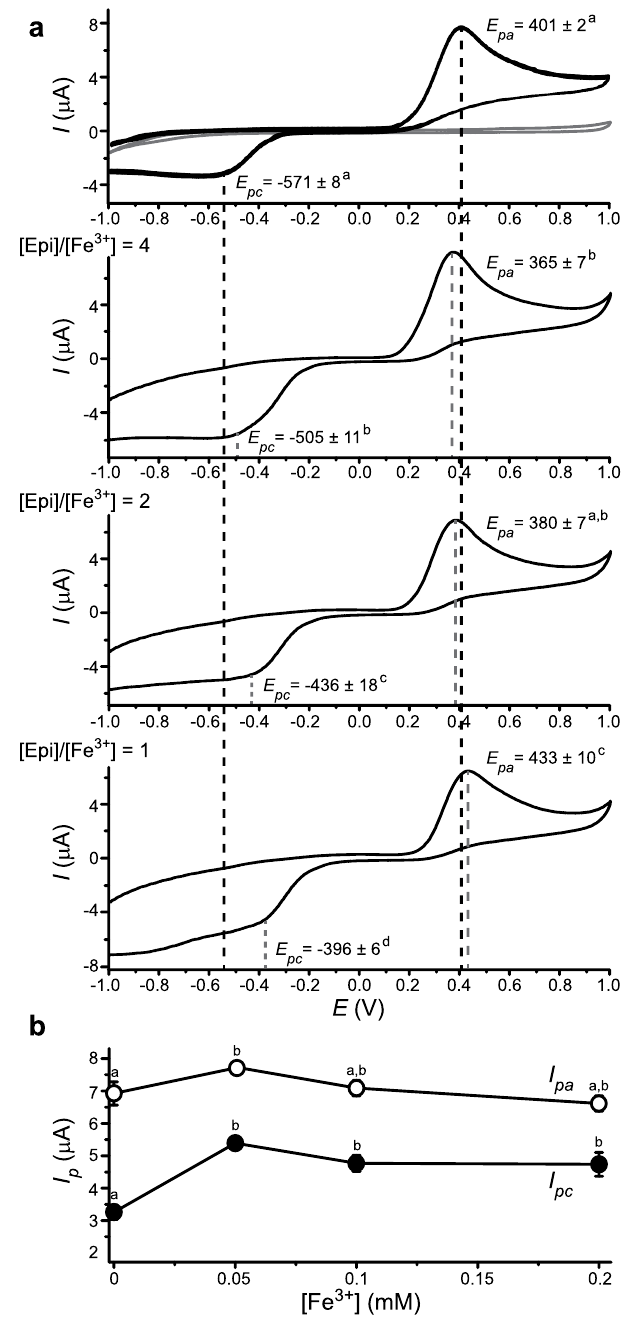
Figure 4. Cyclic voltammograms of 0.2 mM Epi in 10 mM Tris buffer, pH 7.4, containing different Fe 3 + concentrations, at the boron doped diamond electrode. ( a ) From top to bottom: Epi (dark lines) and Fe 3 + (0.2 mM; pale line), and [Epi]/[Fe 3 + ] = 4, 2, and 1. The positions of oxidation/anodic ( E pa ) and reduction/ cathodic ( E pc ) potentials are marked with dotted lines (dark – iron-free system; pale – all other settings). E pa and E pc are presented as mean values ± SE (mV). ( b ) Mean values ( ± SE) of anodic ( I pa ; open circles) and cathodic ( I pc ; closed circles) peak currents in CV of Epi with different [Fe 3 + ]. Scan rate was 0.1 V/s. E pa and E pc , and I pa and I pc not sharing a common letter were significantly different (P <